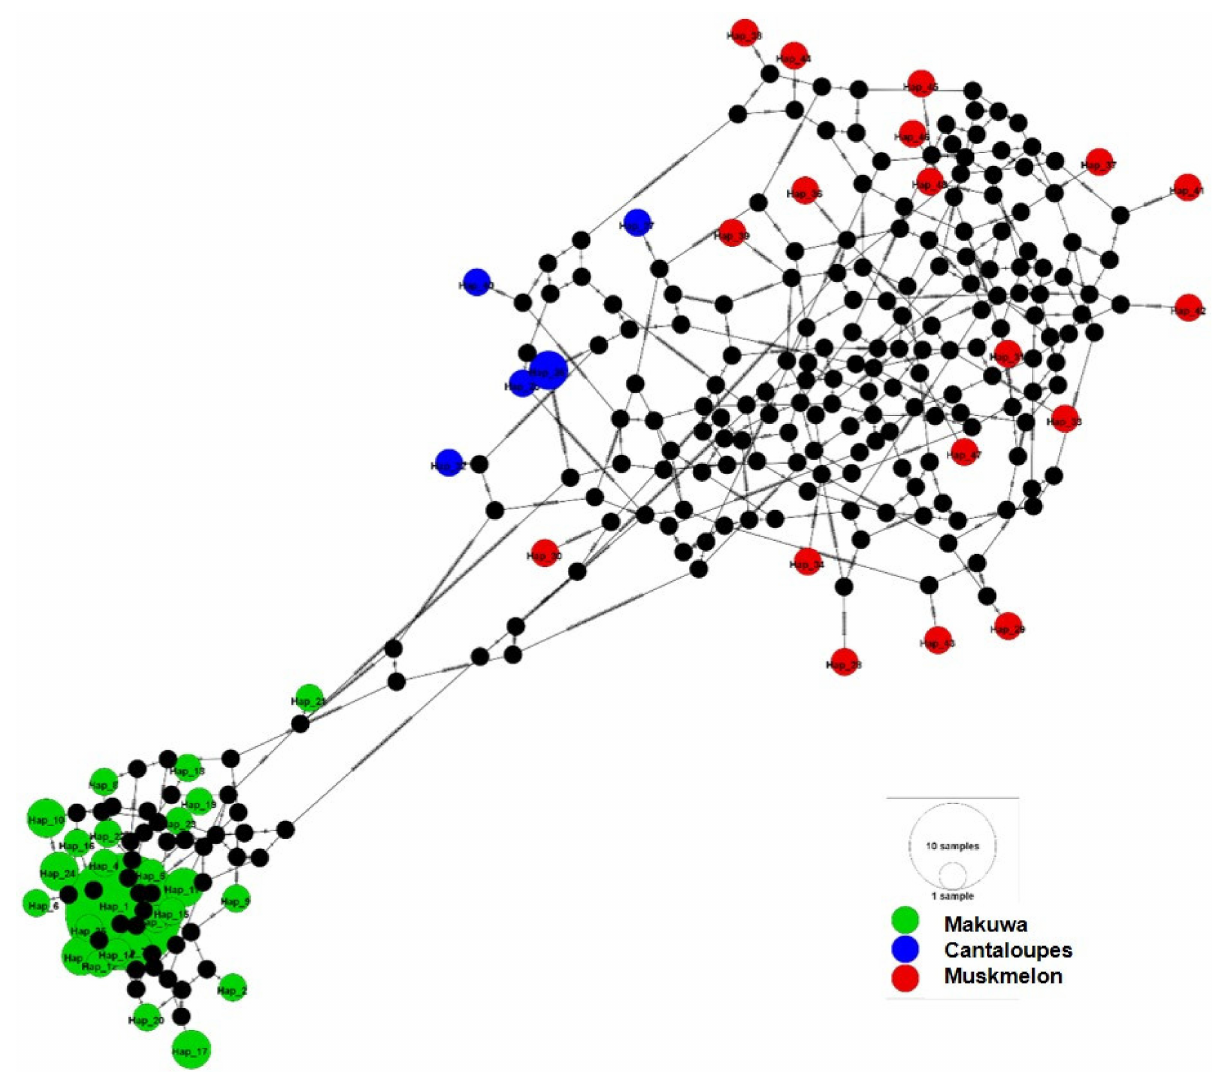
Figure 4. Haplotype network analysis calculated for 72 melon accessions using the integer neighbor-joining haplotype network. The integer neighbor-joining network was generated in PopArt with the reticulation tolerance set to the default value of 0.5. Individual hatch marks on the lines connecting haplotypes indicate mutations. The black dots indicate inferred intermediate